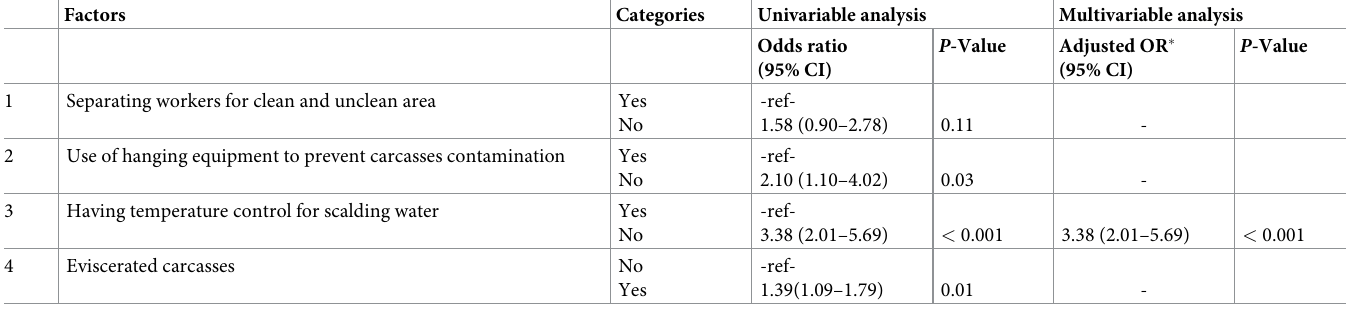
Table 4. Factors associated with the Enterococcus spp. non-compliance of meat samples based on the univariable and multivariable mixed-effects logistic regression.